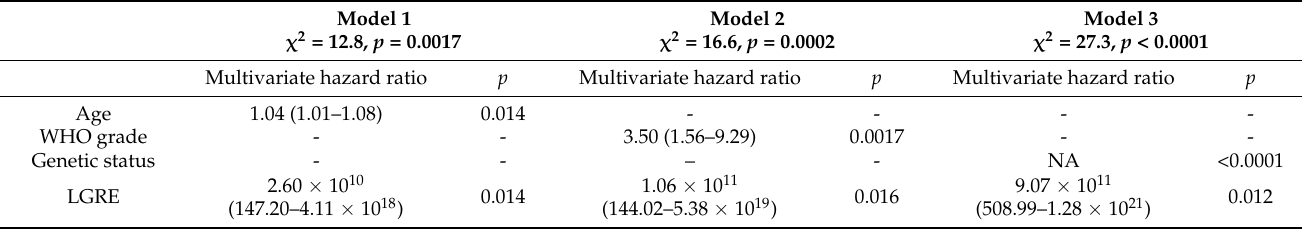
Table 4. Multivariate associations with all-cause death for LGRE.